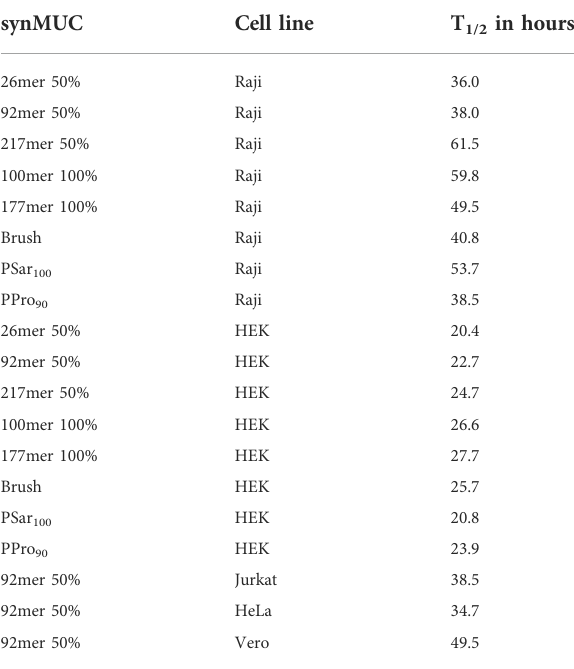
TABLE 1 Calculated half-lives for the synMUC panel in a variety of adherentandsuspensioncelllines.Datausedinthesecalculations is shown in Figure